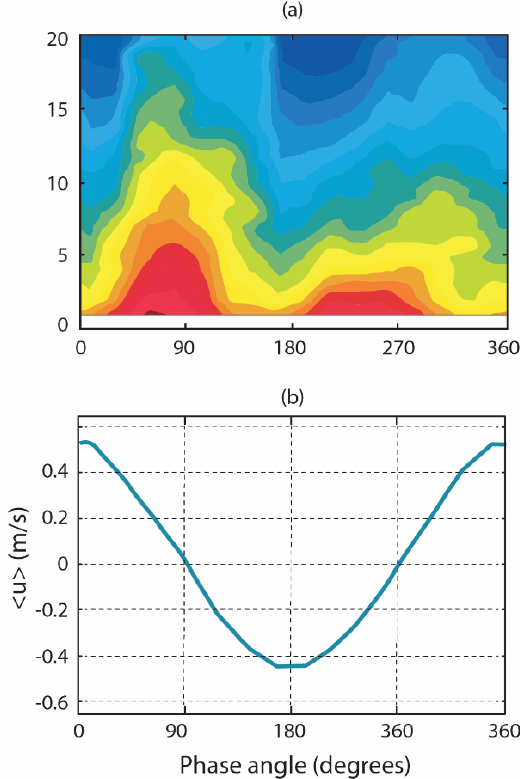
Figure 12. ( a ) Intra-wave variation in SSC with elevation above the bed (measured in cm), plotted against wave phase for a laboratory experiment over a mobile rippled bed. Warm colors indicate large SSC. Panel ( b ) shows ensemble-averaged orbital velocity. Positive velocities are onshore directed. Adapted from O’Hara Murray et al. [84] with permission from John Wiley and Sons.